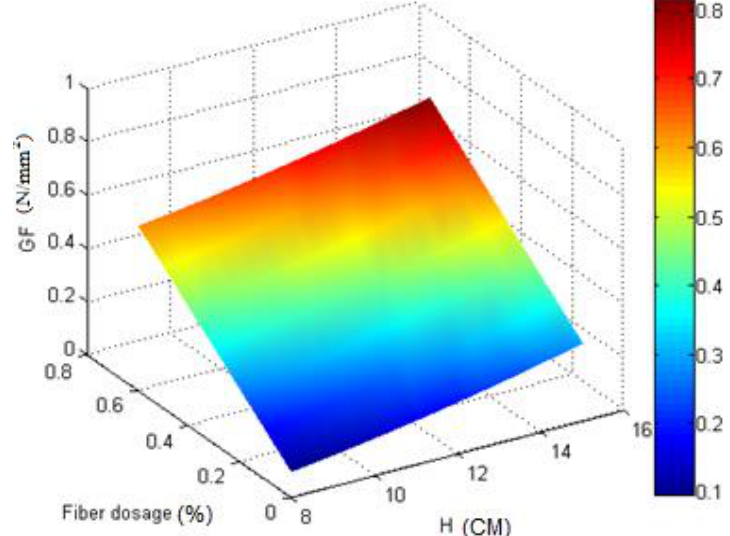
Figure 6. The relationship between G F , H , and Fiberdosage.